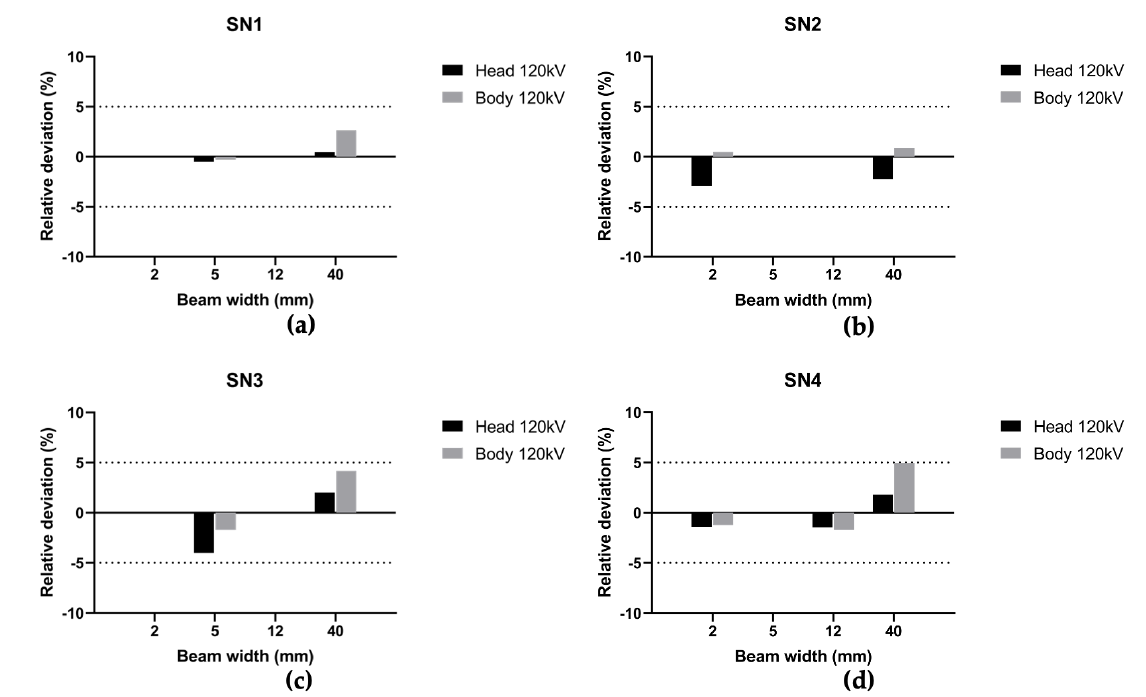
Figure 6. Relative deviation between 𝐶𝑇𝐷𝐼 𝑤𝐼𝑉𝐼𝑠𝑐𝑎𝑛 and 𝐶𝑇𝐷𝐼 𝑤𝑐ℎ𝑎𝑚𝑏𝑒𝑟 , [∆𝐶𝑇𝐷𝐼] 𝑟𝑒𝑓𝐼𝑉𝐼𝑠𝑐𝑎𝑛 , at 120 kV for head and body phantoms over the thinnest and the most used beam width in clinic for ( a ) SN1, ( b ) SN2, ( c ) SN3 and ( d ) SN4.